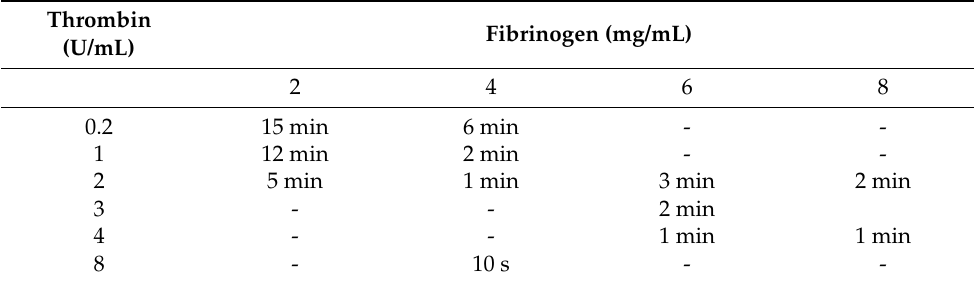
Table 1. Gelation time as a function of fibrinogen and thrombin concentration.